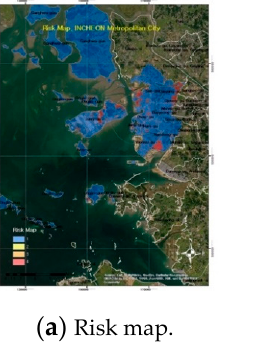
Figure 8. Fundamental map for storm and flood insurance management.